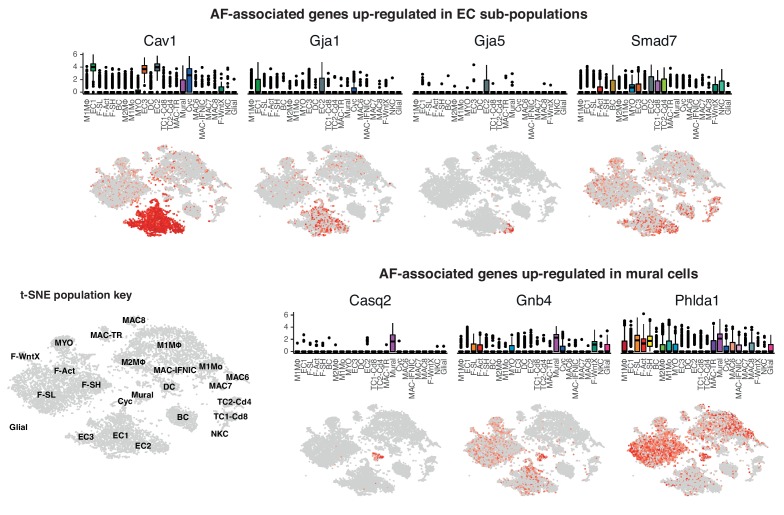
Atrial Fibrilation (AF) associated genes in TIP.Overlap of genes associated with AF from Roselli et al. (2018) and genes upregulated in TIP sub-populations with log2 fold-change >1. Displayed are genes upregulated in EC (top) or mural (bottom) cell sub-populations with expression visualized in box and t-SNE plots. Key indicates the location of sub-populations on the t-SNE plot.